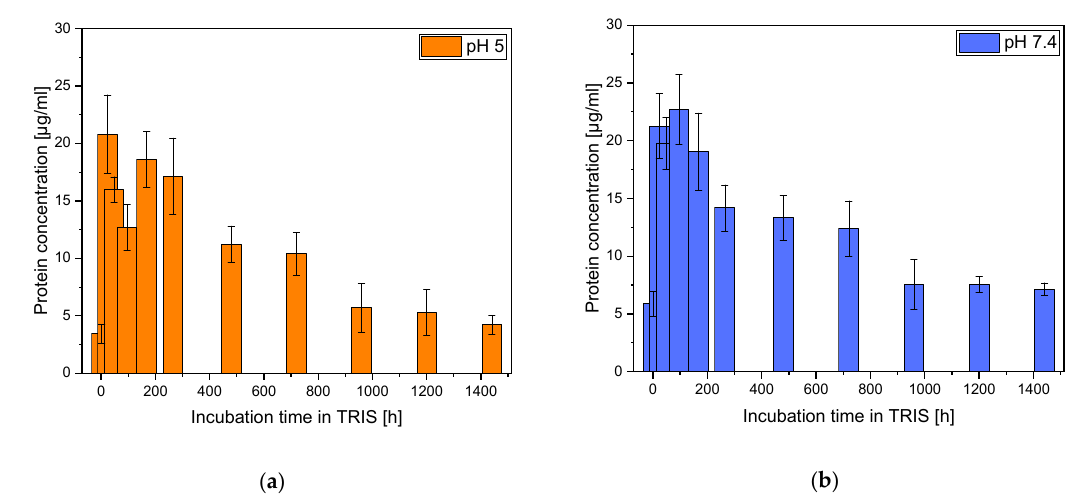
Figure 7. Overview of protein release out of the alginate–alginate-di-aldehyde (ADA-gelatin) hydrogel; ( a ): pH 5.0; ( b ) pH 7.4 .